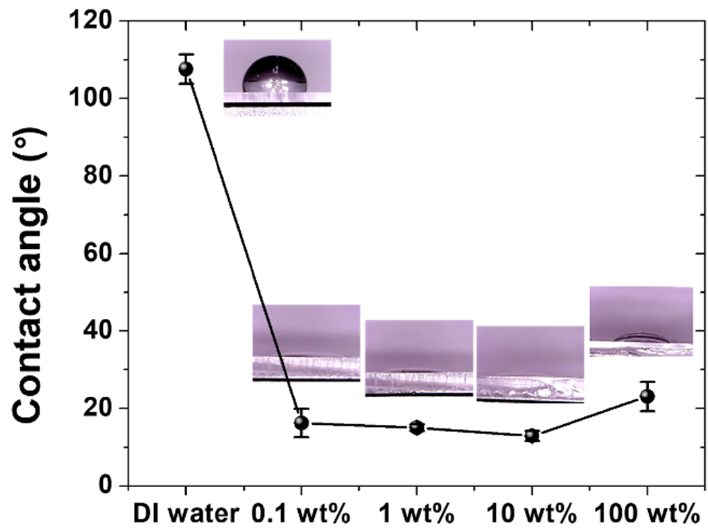
Figure 2. Contact angles of lubricants.